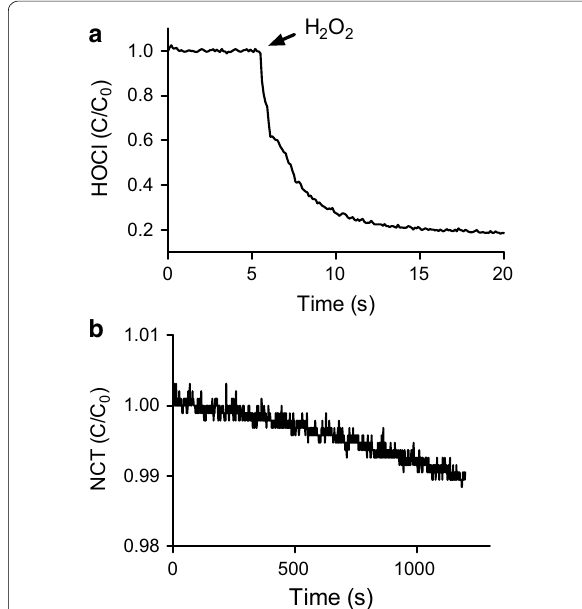
Fig. 1 Reaction of HOCl ( a ) and NCT ( b ) with H 2 O 2 . The reactions were monitored by HOCl and NCT absorbance decay. One repre- sentative experiment of 3 independent ones with similar outcome is depicted